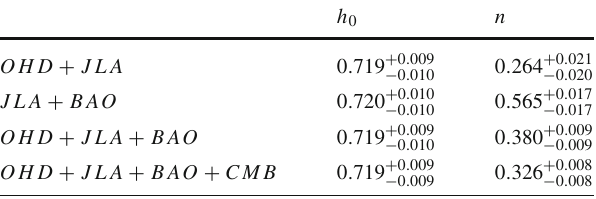
Fig. 6 i Confidence contours on the parameter space and the marginal- ized likelihood function of Model I I I , obtained from the combined analysis of OHD + JLA + BAO + CMB are shown on the figure on top. The associated 1 σ , 2 σ confidence contours are shown. ii Confidence contours on the parameter space and the marginalized likelihood func- tion of Model IV , obtained from the combined analysis of OHD + JLA + BAO + CMB are shown on the figure below. The associated 1 σ , 2 σ confidence contours are shown Table 2 The parameter values and the associated 1 σ uncertainty of the parameters of Model IV , obtained from the analysis with different combinations of the data sets